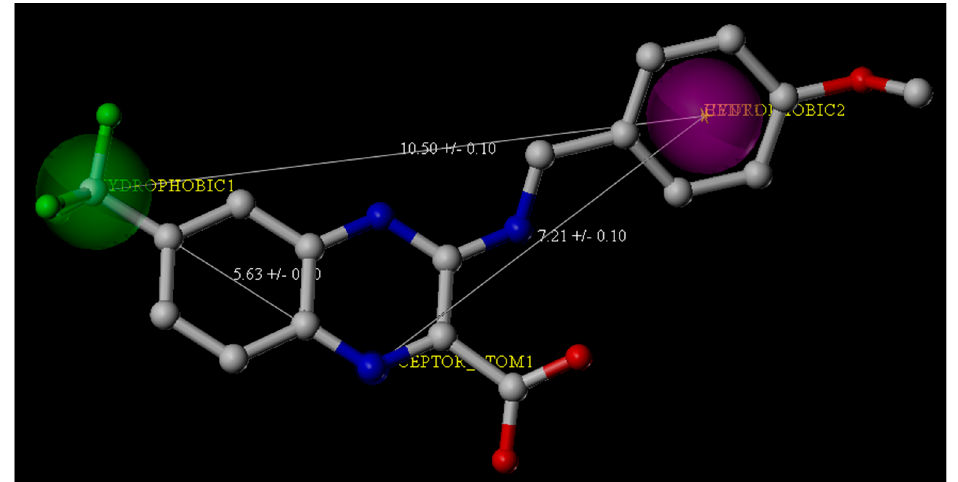
Figure 2. Pharmacophore features derived from the crystal structure of the M. tuberculosis DprE1 complex with Ty38c (the Protein Data Bank Code: 4P8K). Ty38c is shown as the stick structure. Green and purple spheres indicate the hydrophobic groups, and the blue spheres indicate the hydrogen bond donors.